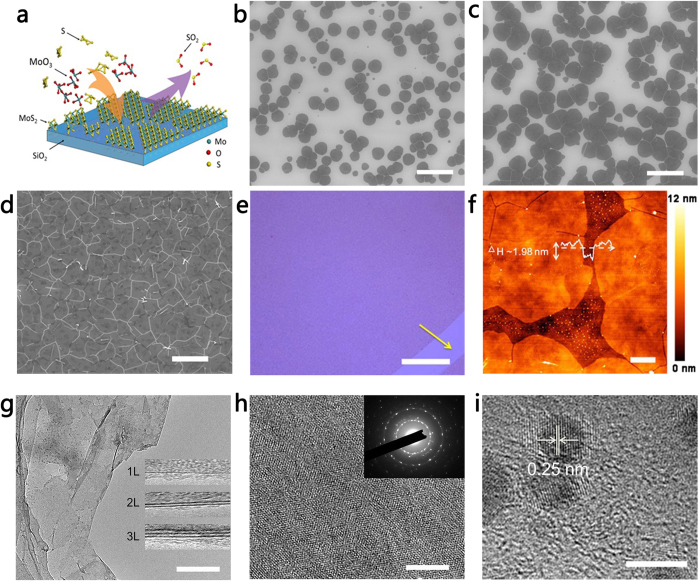
Material characterisations of MoS2and GQDs.(a) Schematic diagram showing the chemical reaction on a SiO2 substrate for the production of MoS2. (b–d) SEM images showing different growth stages of MoS2 with reaction times of 5, 10 and 30 min, respectively. Scale bars in (b–d): 20 μm. (e) Optical image of MoS2 on a SiO2 substrate. The yellow arrow indicates a scratch. Scale bar: 50 μm. (f) AFM topography of a MoS2 film on a SiO2 substrate. The white profile indicates three atomic layers. Scale bar: 1 μm. (g) TEM image showing a folded MoS2 film. Scale bar: 200 nm. The inset shows the folded edges of monolayer (1L), bilayer (2L) and trilayer (3L) MoS2 films. (h) HRTEM image of a MoS2 film. The scale bar is 5 nm. The inset shows the corresponding electron diffraction pattern. (i) HRTEM image of GQDs. Scale bar: 2 nm.